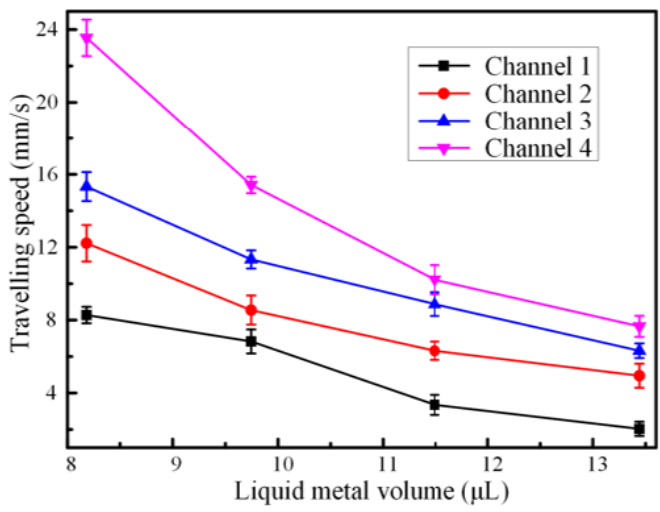
Figure 5. Plot of average actuation velocity versus liquid metal volume when a 150 Hz sinusoidal wave signal at 4 Vpp with 4 V DC o ff set was applied at the driving